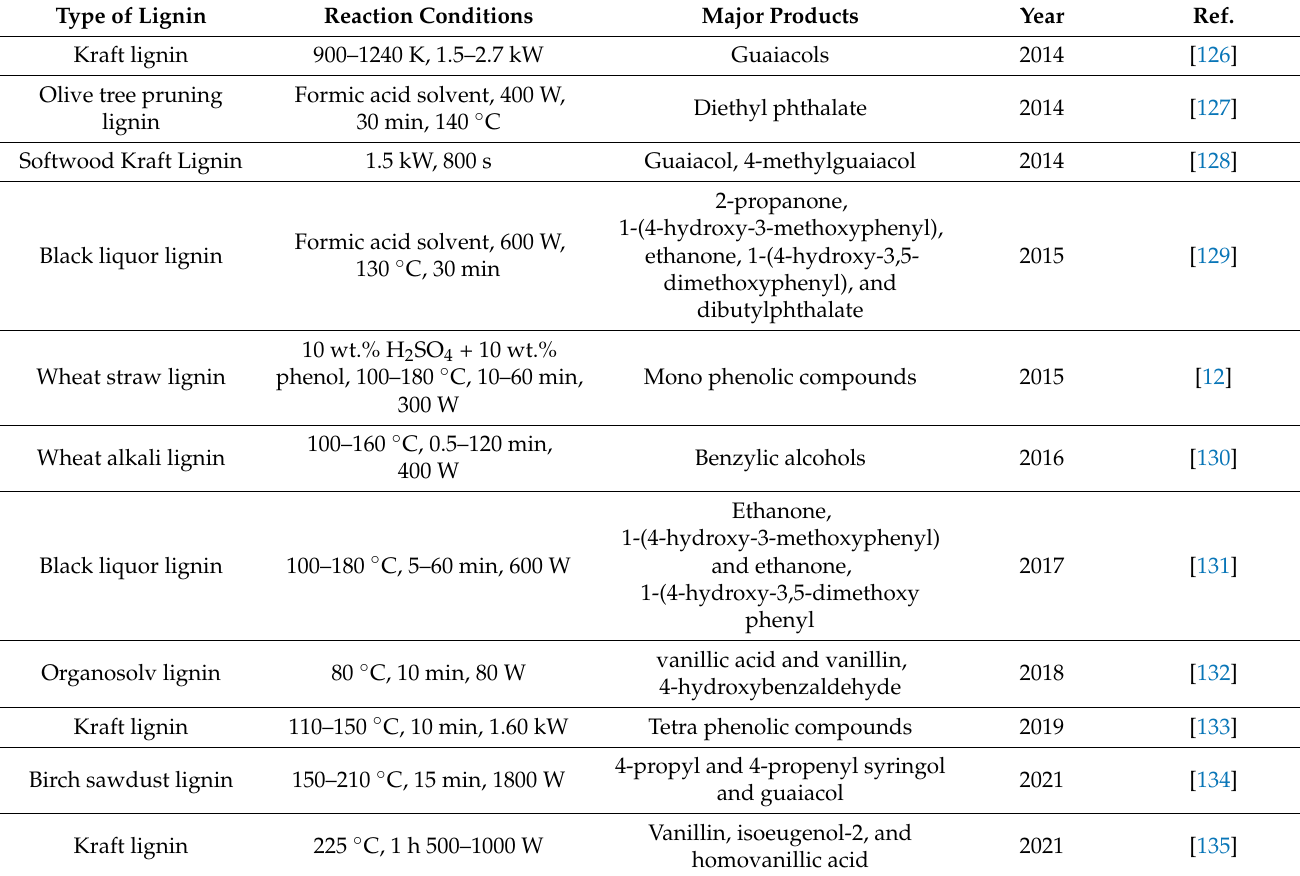
Table 6. Depolymerization of lignin by microwave